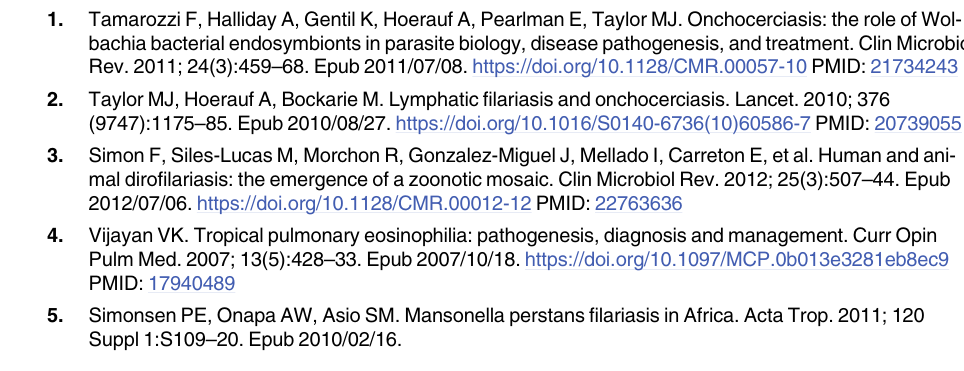
S2 Table. Parasitological outcomes in different immunomodulated mice after Litomo- soides sigmodontis infection. The 1 st column indicates the mouse strain; the 2 nd column pre- cises the filarial developments according to the mouse strain; the 3 rd column indicates the molecular/cell target of the immunomodulation; the 4 th column gives the immunomodulatory tool (knock-out or transgenic mice, treatments with antibodies or drugs); the 5 th column indi- cates the main functional cell target; the 6 th one summarize the effect of the immunomodula- tion on the parasitological outcomes and the 7 th column is for the references. Mac: macrophages; Eos: eosinophils; Neu: neutrophils; rIL-5: recombinant IL-5; " : increase; # :